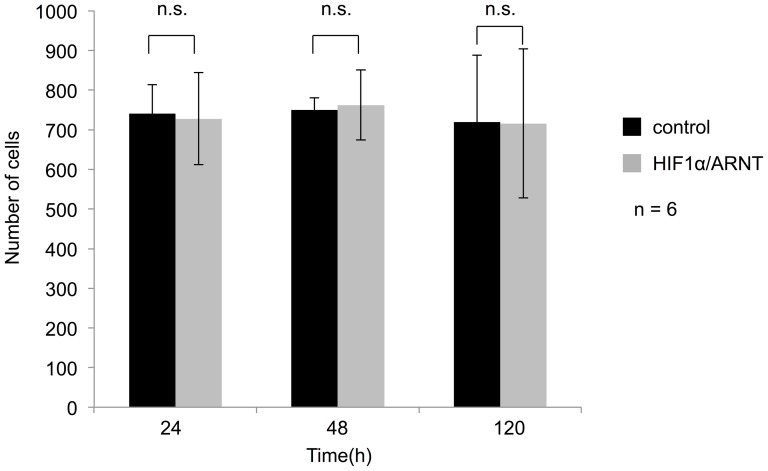
The effects of HIF1α/ARNT on the number of NIH3T3 cells.NIH3T3 cells were co-transfected with the Per2 promoter reporter (400 ng) and the indicated expression plasmids (300 ng) for HIF1α/ARNT or empty vector pcDNA3 (600 ng) as a control. Plates were read on the ArrayScan XTI (Thermo Scientific) for cell count indicated time after dexamethasone treatment. Numbers of viable cells were not affected by HIF1α/ARNT at all time points (mean ± SEM, n = 6, Student's t-test).